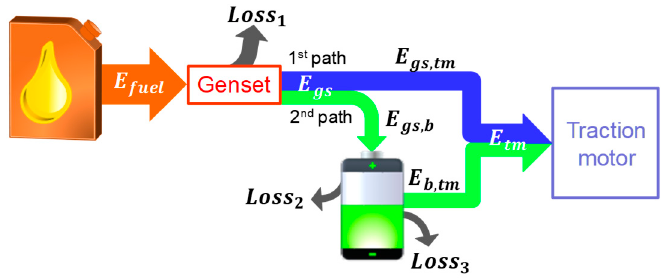
Figure 19. Energy flow diagram of the REEV.